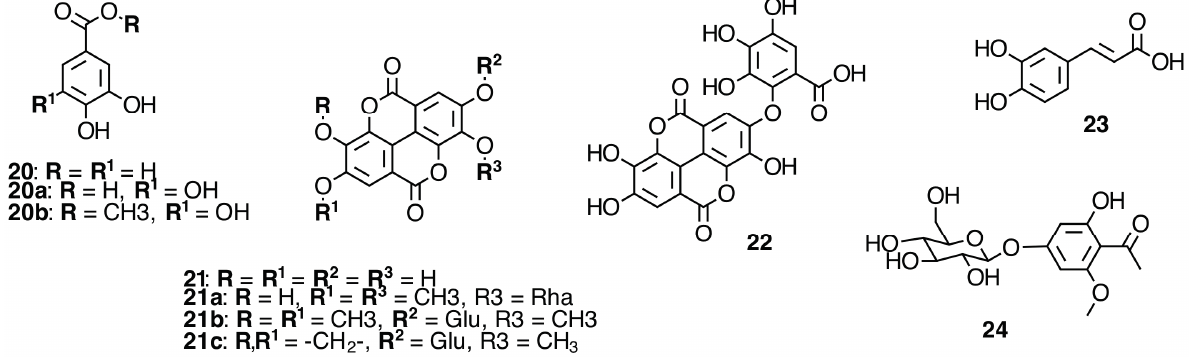
Figure 5. Phenolic acids and glycosyl derivatives isolated from melastomataceae